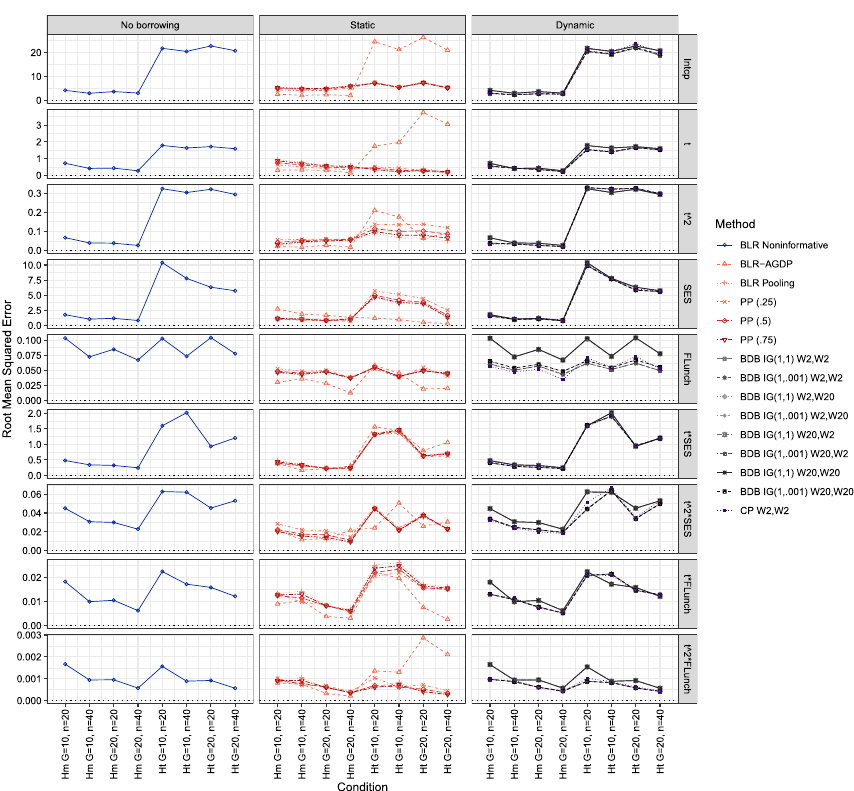
Fig. 2 Root Mean Squared Error (RMSE) of regression coefficient estimates for different sample size and heterogeneity